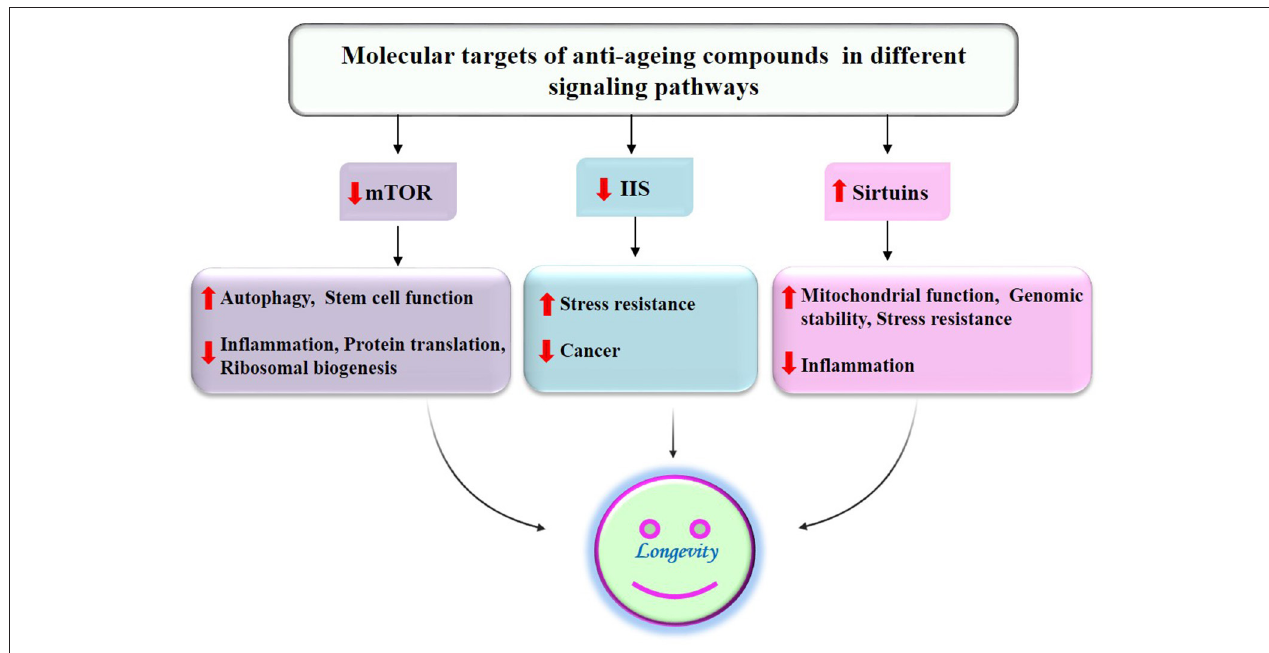
FIGURE 7 | Suppression of aging and age-associated diseases by antiaging compounds of millets through modulation of different signaling pathways by acting on their molecular